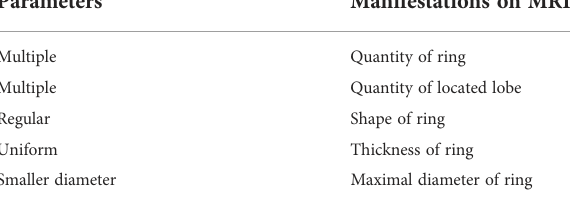
TABLE 2 Diagnostic criteria of GBM with MUT BRAF.